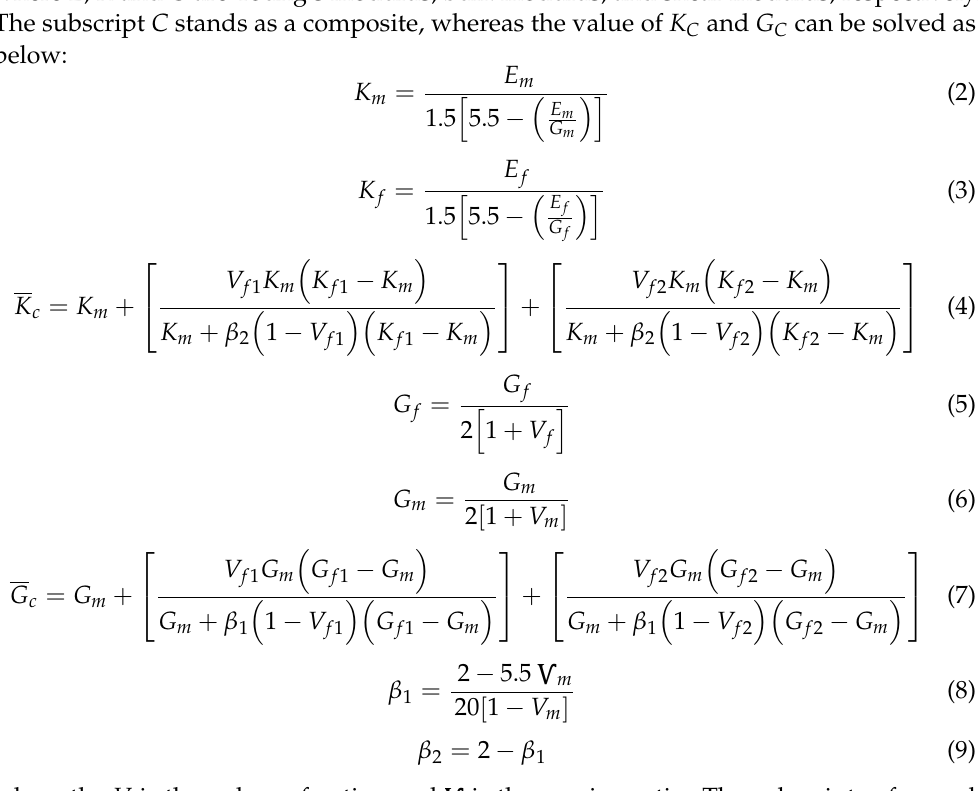
Figure 6. Comparison between the new model and experimental data.